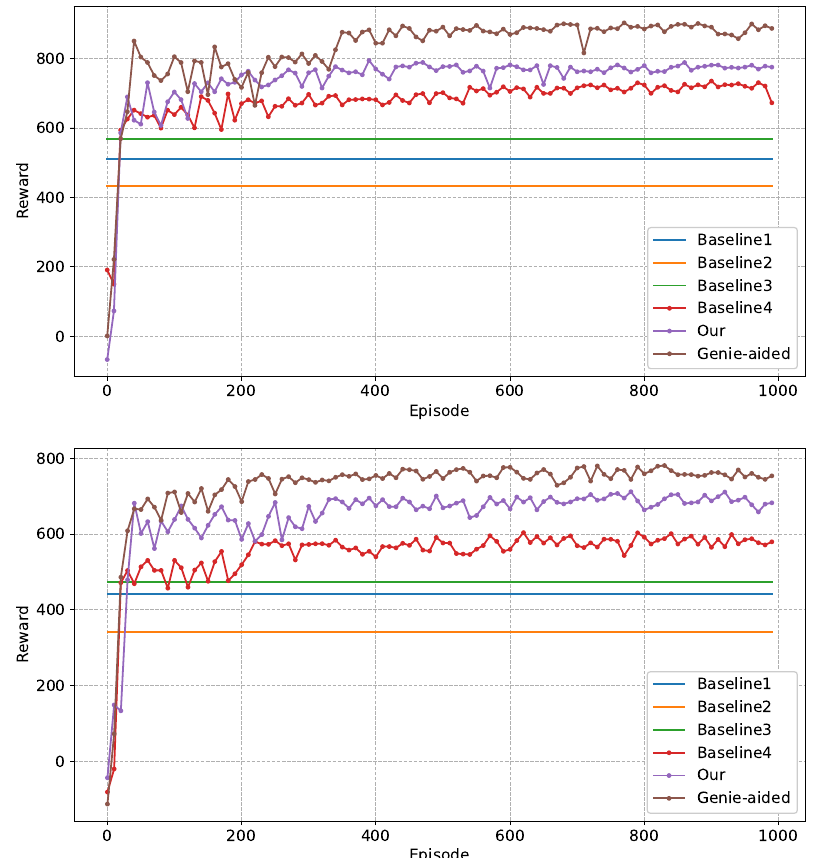
Figure 9. Reward convergence of the DQN method for the prototyping result and the comparison of reward among different methods. The top is for single interference source, the bottom is for double interference source.